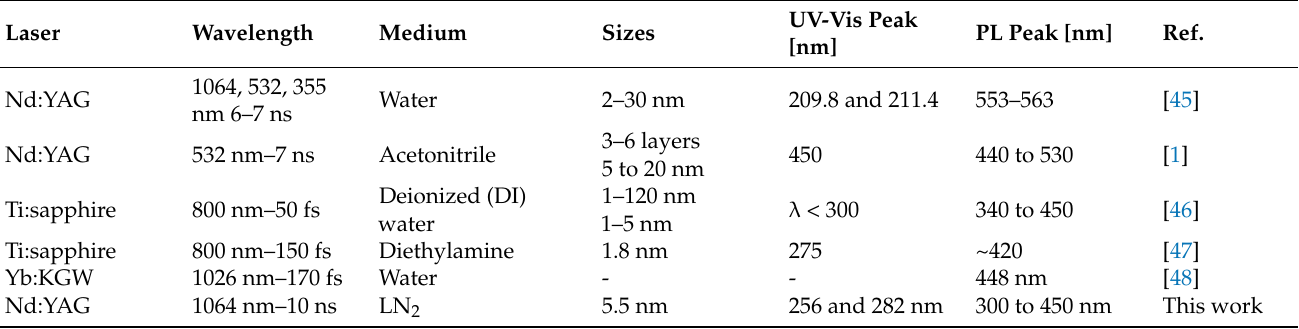
Table 1. Characteristics of PLA-synthesized MoS 2 QDs in different media.